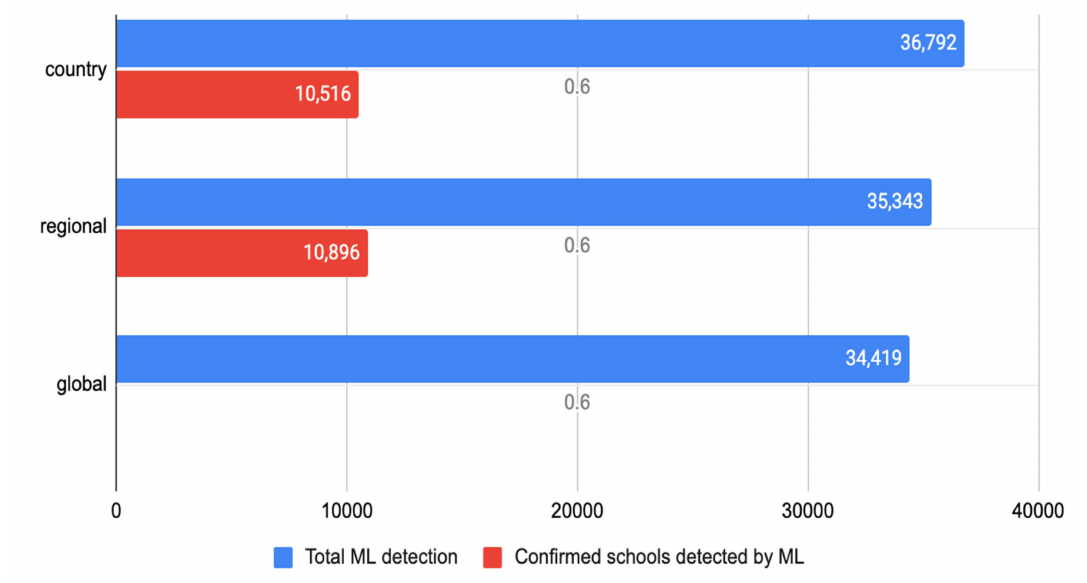
Figure 14. Model performance in